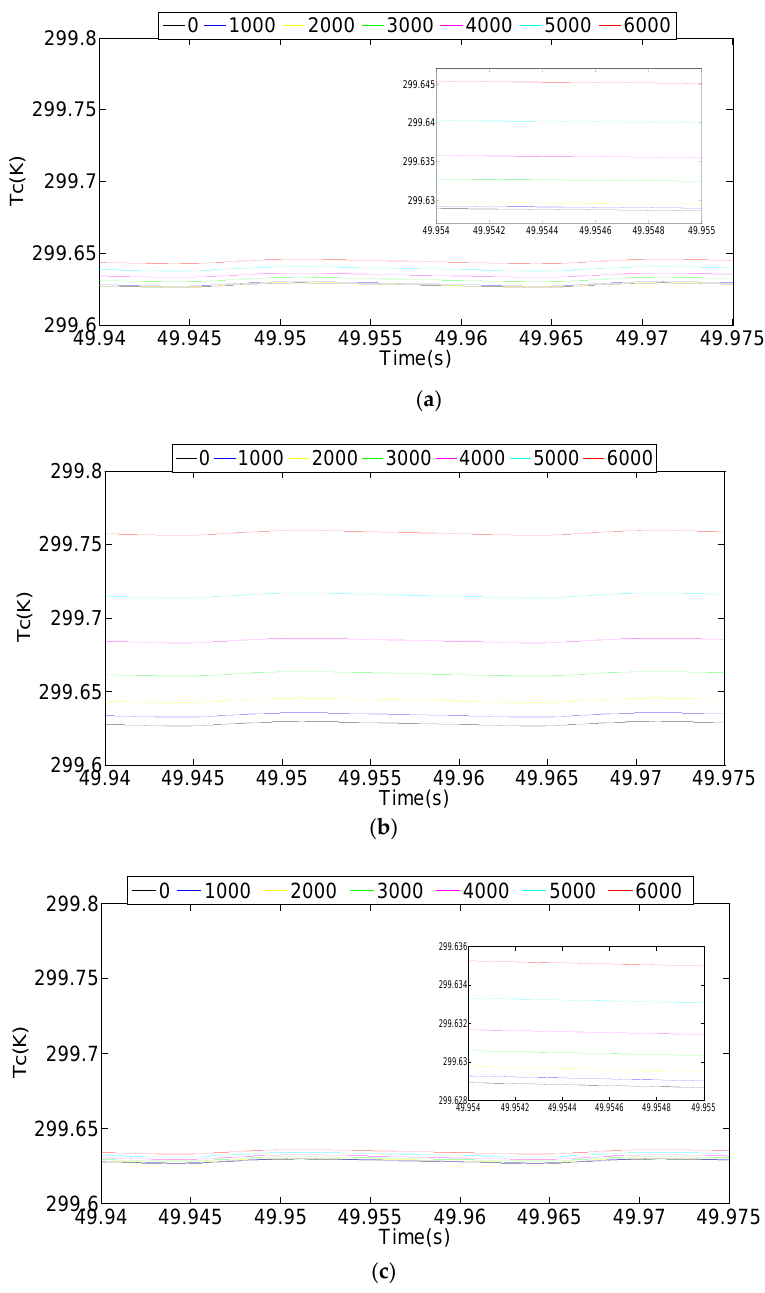
Figure 10. The steady state case temperature with the change of electro-thermal parameters. ( a ) The steady state case temperature with the change of V ceo and r ce ; ( b ) The steady state case temperature with the change of E on and E of f ; ( c ) The steady state case temperature with the change of Z th , jc . Comparing the subfigures (a), (b) and (c) in Figure 9, the threshold voltage and on-resistance have the least effect on the junction temperature, the switching loss has a larger effect on the junction temperature, and the thermal impedance has the largest effect on the junction temperature. Comparing subfigures (a), (b) and (c) in Figure 10, the thermal impedance has the least effect on case temperature, and the threshold voltage and on-resistance have small effect on case temperature, and the switching loss has the greatest effect on case temperature. The thermal impedance can directly reflect the fatigue degree of the solder layer, which has the greatest effect on the junction temperature and has the least effect on the case